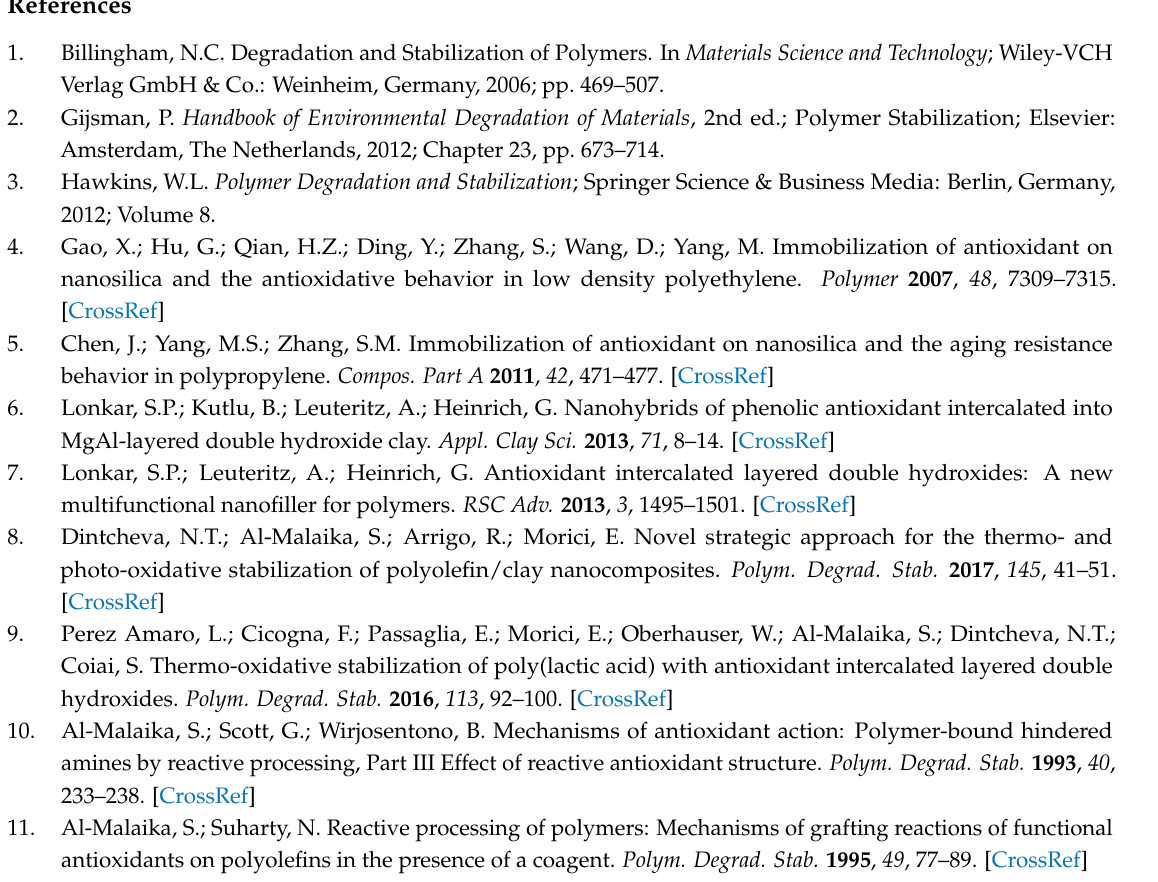
determination of the amount of CY and BHB-T released from EOC/CY2 and EOC- g -(BHB-T)_2 during migration tests, Figure S5: FT-IR spectrum of 3,5-di- tert -butyl-4-hydroxybenzoyl-2,2,6,6-tetramethylpiperidine-1-oxyl radical (BHB-T), Figure S6: ESI mass spectra registered in positive mode, in the mass range 200–300 m / z , of the products extracted from EOC- g -(Bz-T) virgin sample (a) and photo-oxidized for 6 days (b), Figure S7: Differential MWD of EOC- g -(Bz-T) before and after different UV irradiation times, Figure S8: M n variation as a function of irradiation time, Figure S9: Intrinsic viscosity variation as a function of irradiation time, Figure S10. Deconvoluted IR spectrum of EOC thermo-oxidized for 30 days in the absorption region of carbonyl group, Figure S11: Oxidation induction time (OIT) curves of pristine EOC, EOC functionalized with Bz-T and BHB-T and EOC mixed with CY. Acquisition temperature 190 ◦ C, oxygen flow 50 mL/min, Figure S12: Ct / Ceq vs. square root of time (h) of EOC in ethanol for samples: ( • ) EOC- g -(BHB-T)_2; ( (cid:3) ) EOC/CY_2, Table S1: SEC-DV characterization of EOC, EOC- g -(Bz-T) and EOC- g -(BHB-T)_2 during